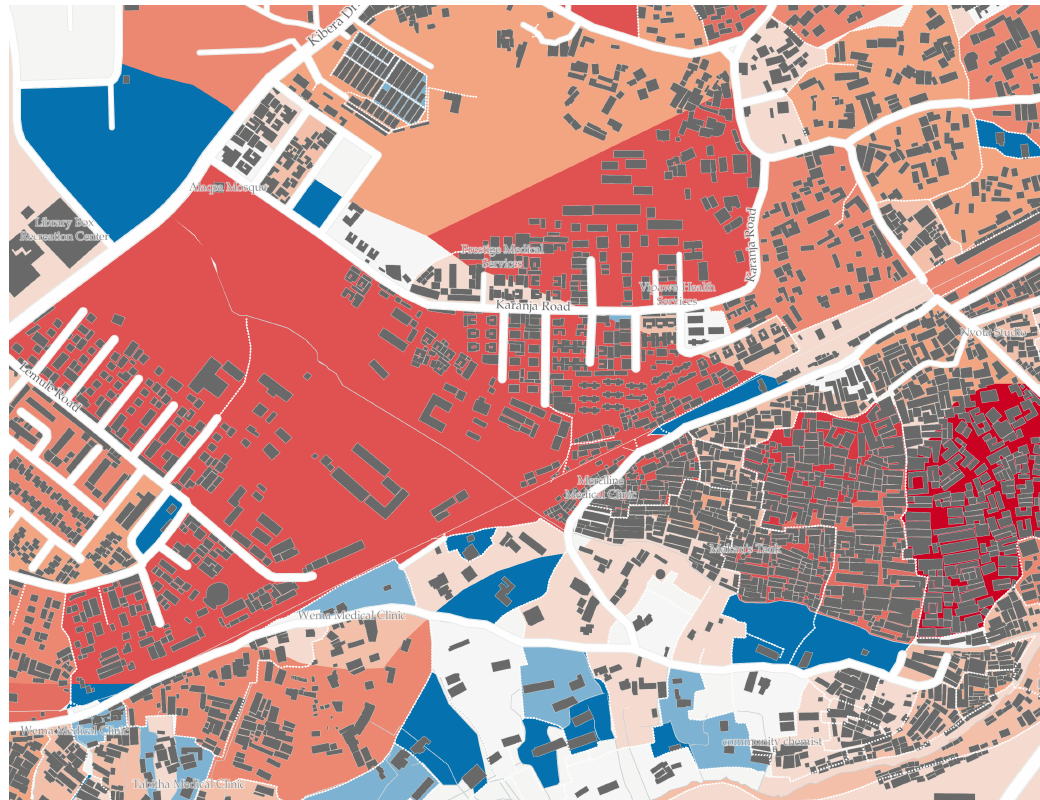
Figure 6. Choropleth of street blocks by complexity. Blocks in Kibera, a slum in southwest Nairobi, Kenya, colored according to block complexity. Blocks with relatively low complexity ( k < 2) are colored blue as each of their enclosed buildings (in grey) have direct access to the surrounding road network. Progressively lighter shades of blue indicate worse access, while shades of orange and red indicate severely impacted access (red for k ≥ 12). This image was exported from the Mapbox Studio backend using OpenStreetMap data, ©Mapbox, ©OpenStreetMap. To view the full interactive map, visit